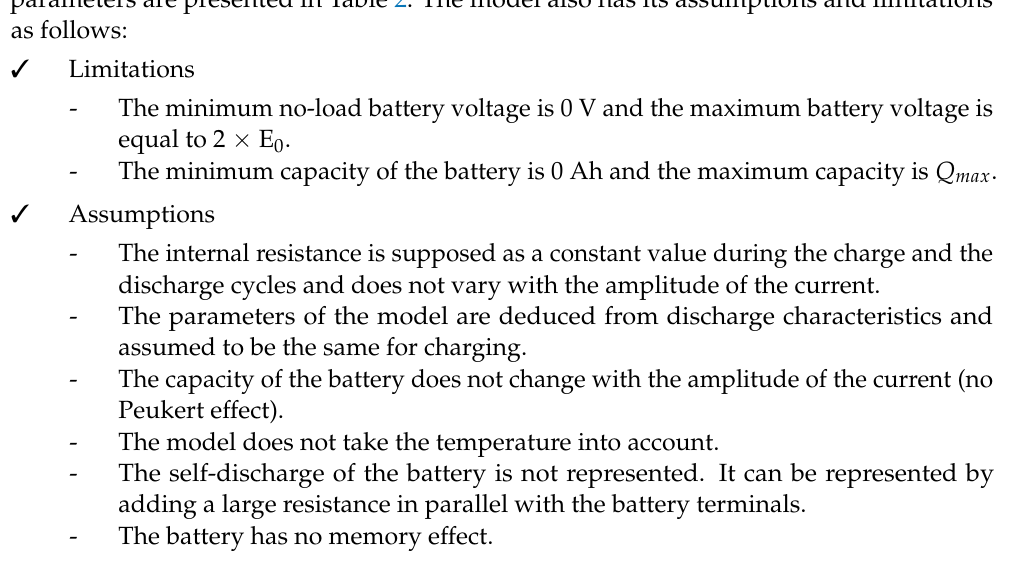
Table 2. Battery parameters: discharge at variable